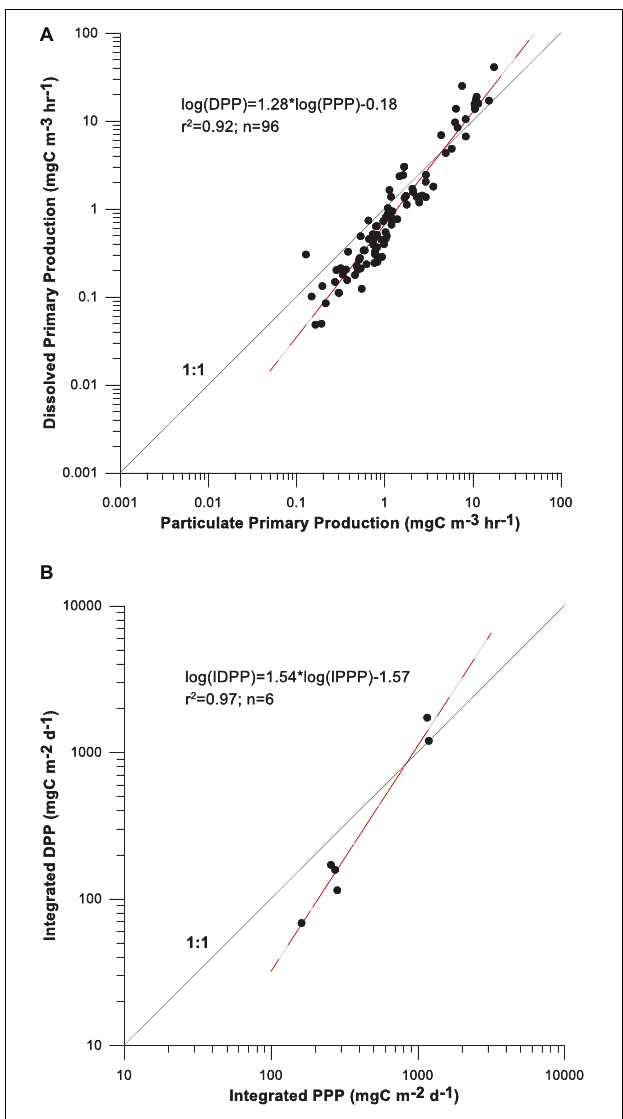
FIGURE 3 | Log-log relationship between particulate (PPP) and dissolved primary production (DPP) with all pooled (A) volumetric; (B) depth-integrated measurements. In both (A) and (B) , the slope of the simple linear regression was significantly greater than 1 ( t -test, p <